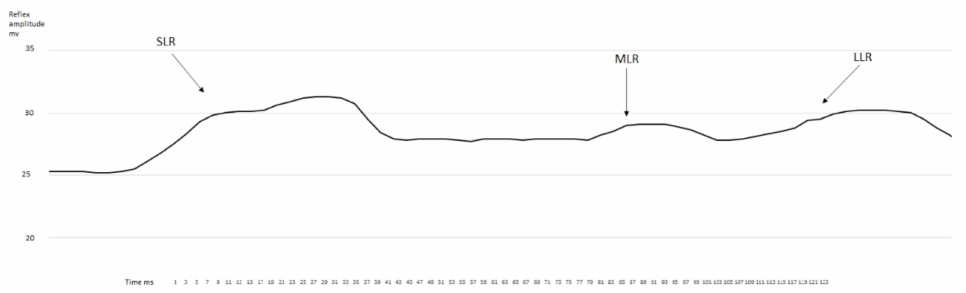
Figure 2. Representative rectified, filtered, and smoothened curve of the EMG activity for the rectus femoris muscle after the fatiguing